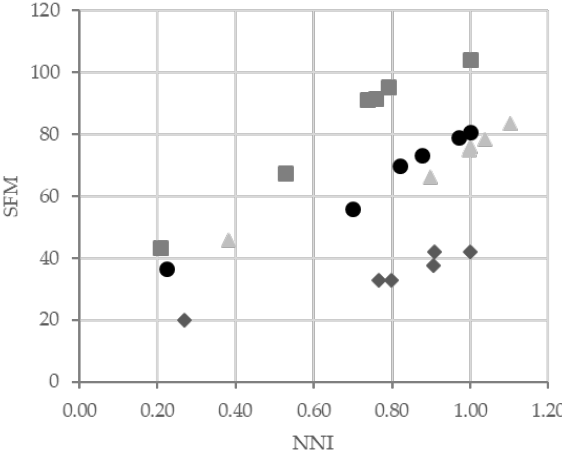
Figure 7. Nutrition Use Efficiency in four Arabidopsis accessions. Shoot fresh matter (SFM) of the four accessions are plotted against their Nitrogen Nutrition Index. Accessions are showed by squares, diamonds, triangles and circles in different shades of grey for Bur-0 , Col-0 , Cvi-0 , and Ge-0 , respectively.